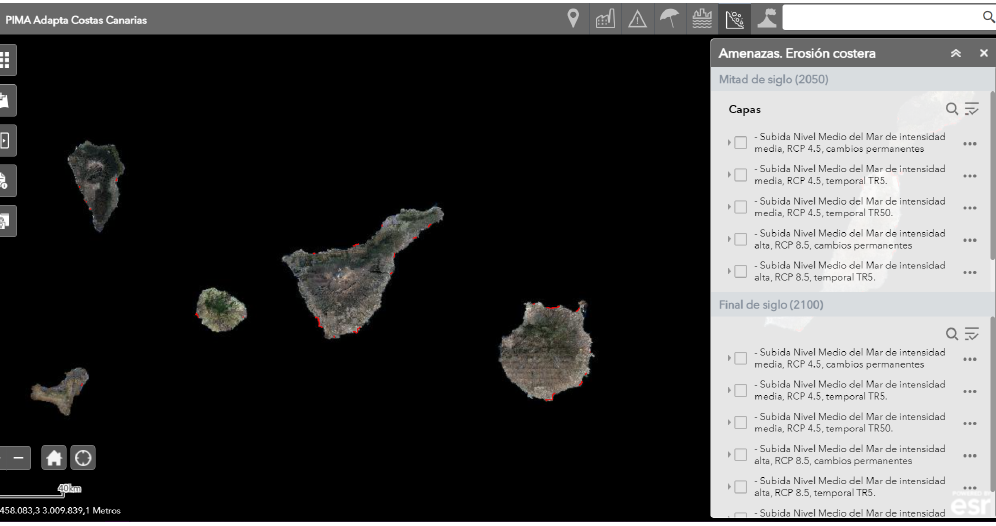
Figure A6. Overview of the resource. Source: GRAFCAN (2022b).